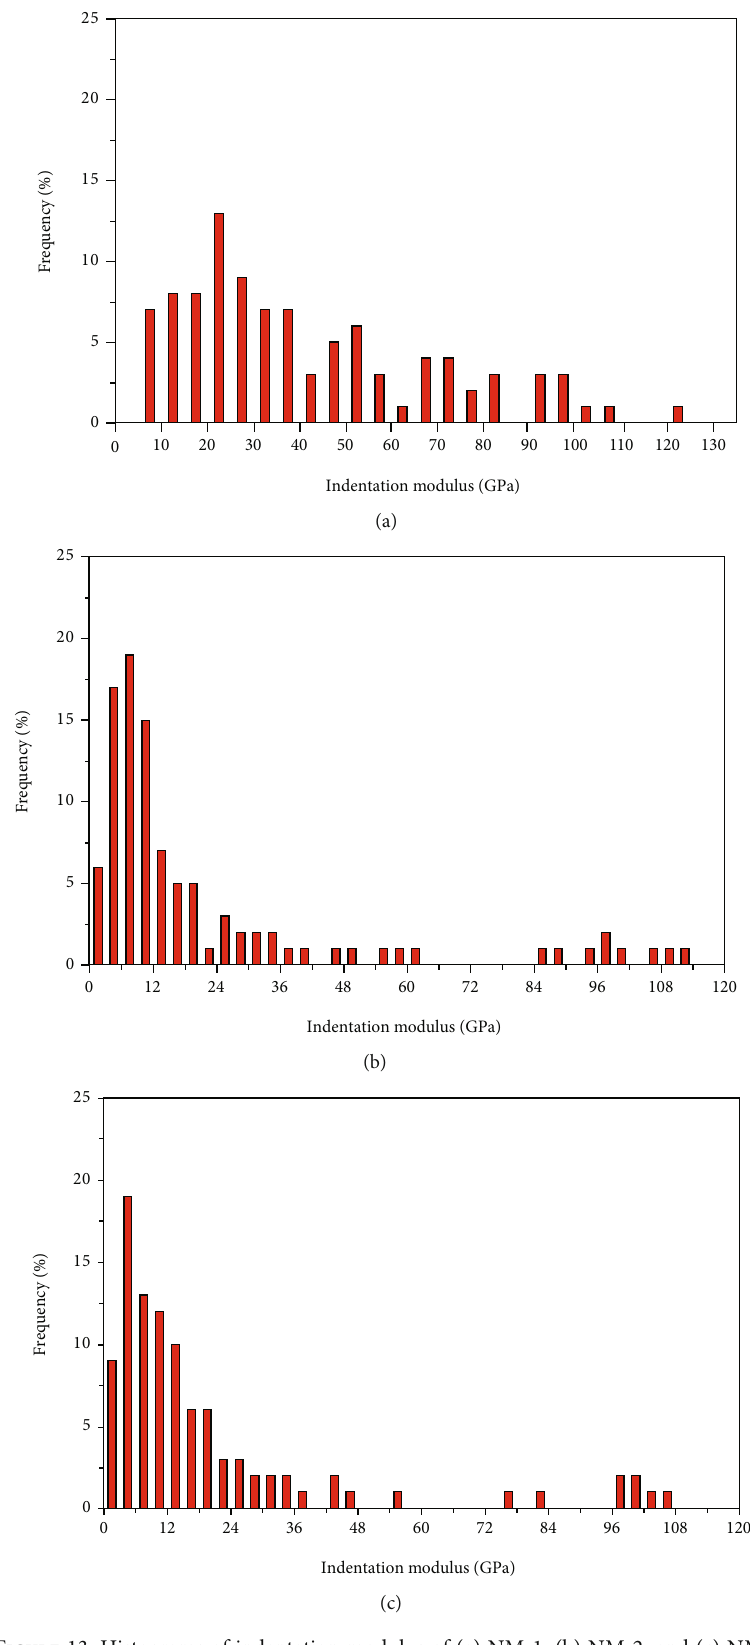
Figure 13: Histograms of indentation modulus of (a) NM-1, (b) NM-2, and (c)